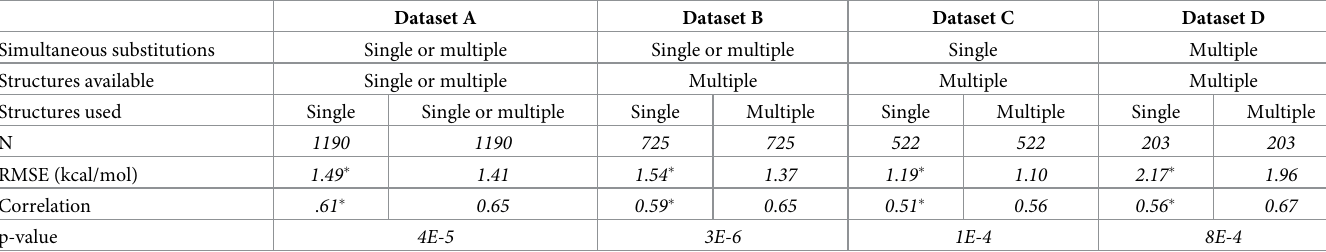
Table 1. Comparison of computing ΔΔ G using single vs. multiple structures, for several subsets of our benchmark